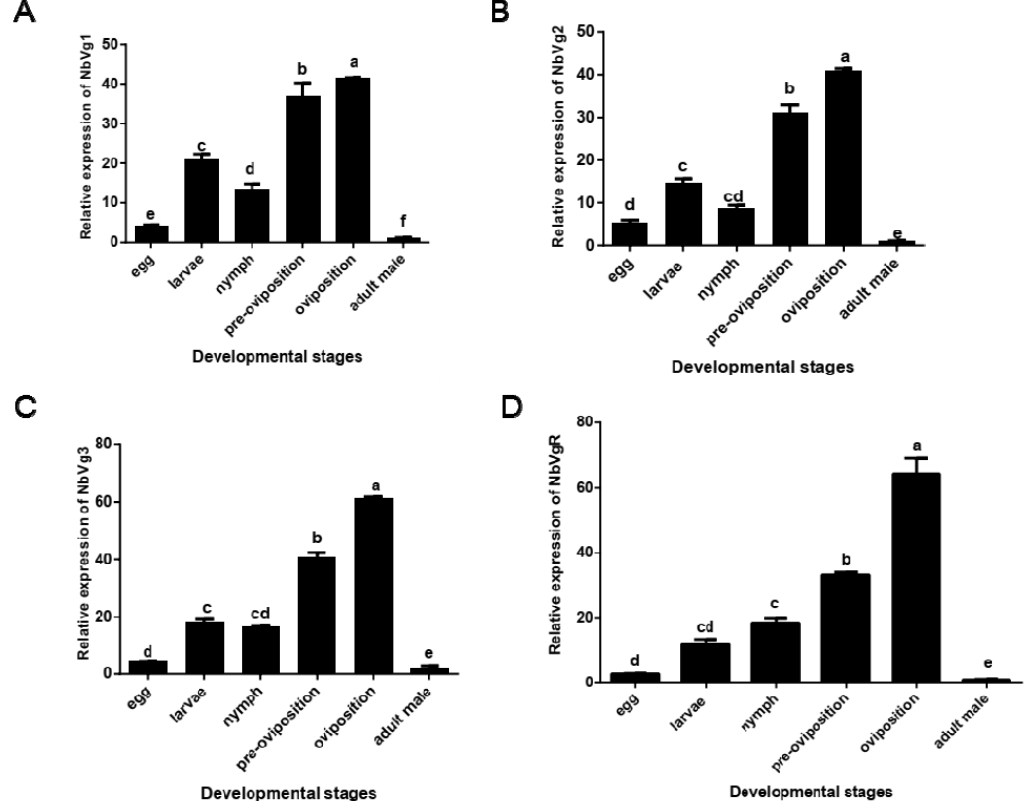
Figure 9. Relative expression of N. barkeri Vgs and the VgR in non-diapause mites at different stages as determined by quantitative polymerase chain reaction (qPCR). ( A ) Relative expression of Vg1. ( B ) Relative expression of Vg2. ( C ) Relative expression of Vg3. ( D ) Relative expression of the VgR. Data are presented as the means of three replicates ± standard error (n = 3). Different lowercase letters indicate significant differences (one-way analysis of variance (ANOVA) with Duncan new multiple range method, p < 0.05).